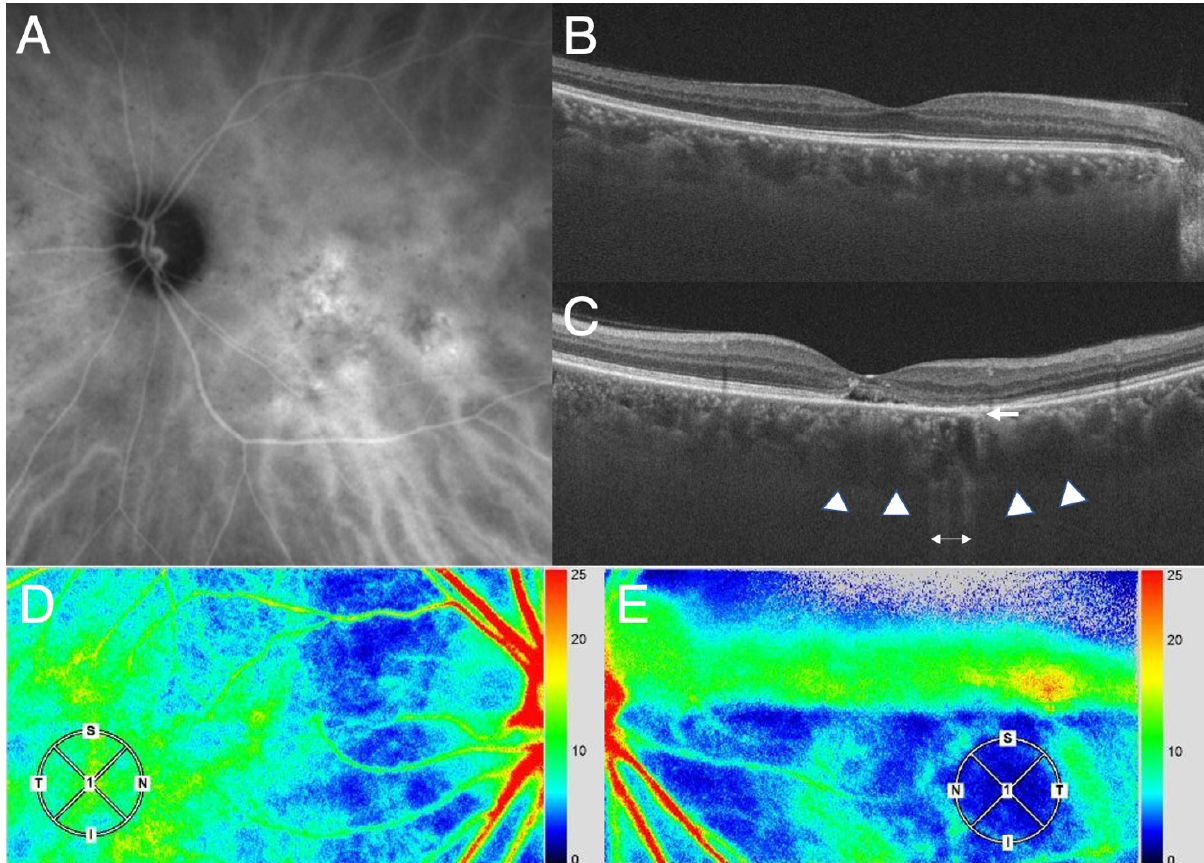
Figure 1. Photographs of the affected eye and the healthy fellow eye of a patient with CSC. ( A ). Indocyanine green angiography shows choroidal vascular hyperpermeability in the macula region. ( B , C ). Horizontal section on optical coherence tomography in the healthy right ( B ) and the affected left eye with CSC ( C ). The CSC eye shows pachyveins and pachychoroid (arrow heads) and attenuation of the choriocapillaris (arrow) at the area with pigment alteration suggested by enhanced light transmission (two-way arrow). ( D ). LSFG in the healthy right eye. The color bar (at the right-side margin) indicates the blood flow speed. The speed is faster toward red and slower toward blue. Note that the blood flow speed in the macula region (within the circle) reflects choroidal blood flow signal because of the lack of retinal vasculature and is only slightly lower compared to that at the adjacent area, which may indicate physiological condition. ( E ). LSFG in the affected left eye. Note that the blood flow speed in the area with choroidal vascular hyperpermeability in A involving the macula region (within the circle) is extremely slow (indicated by blue) compared to that in the surrounding area. Thus, there is a large decrease in the blood flow speed in the area affected by CSC, indicating that there will be a blood pressure rise in the region according to Bernoulli’s theorem.